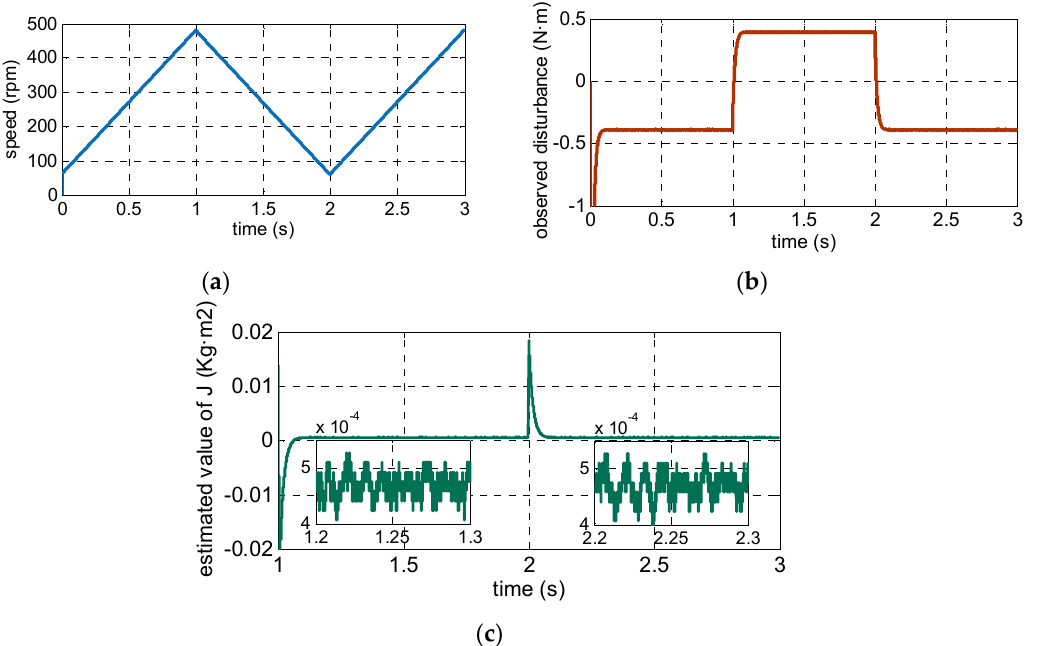
Figure 8. Simulation results under an acceleration of ±420 rpm/s for J 0 = 20 J : ( a ) Measured speed; ( b ) observed disturbance value for parameter mismatch error Δ J ; ( c ) estimated value of parameter J .